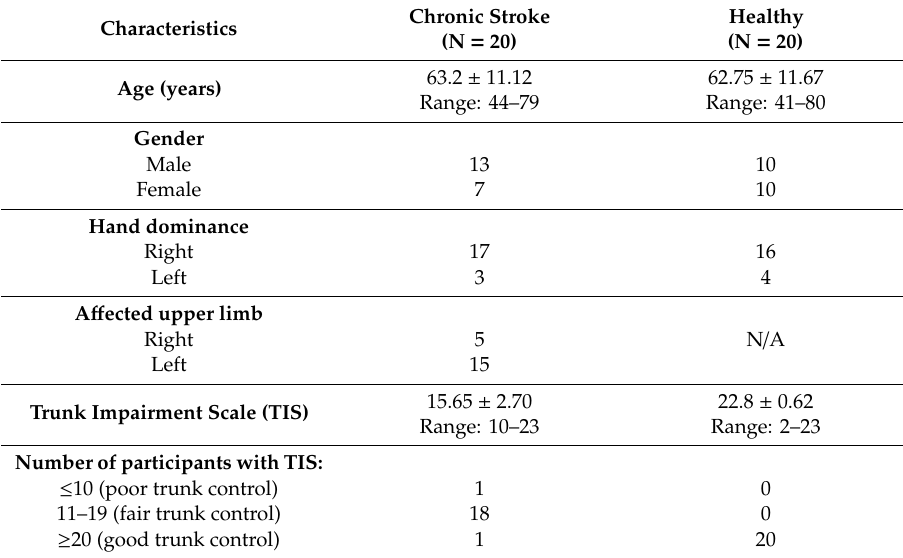
Table 2. Participant Characteristics.